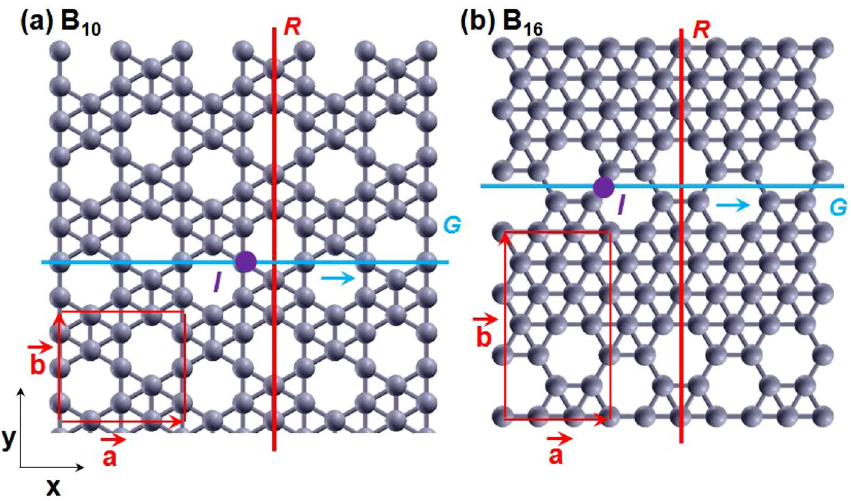
Figure 1. Lattice structure of borophene B 10 ( a ) and B 16 ( b ) with 10 and 16 atoms, respectively, in the unit cell b . B 10 [B 16 ] is obtained from pristine borophene by removing boron atoms a and defined by primitive vectors (cid:31) (cid:31) from the center of hexagons which share one corner [side] along the x -direction. In both ( a,b ), the hollow hexagons form a string along the x -direction, with a zigzag profile in the y -direction. This basic feature yields a nonsymmorphic glide-plane symmetry G (composed of a reflection plane running along the x -direction and